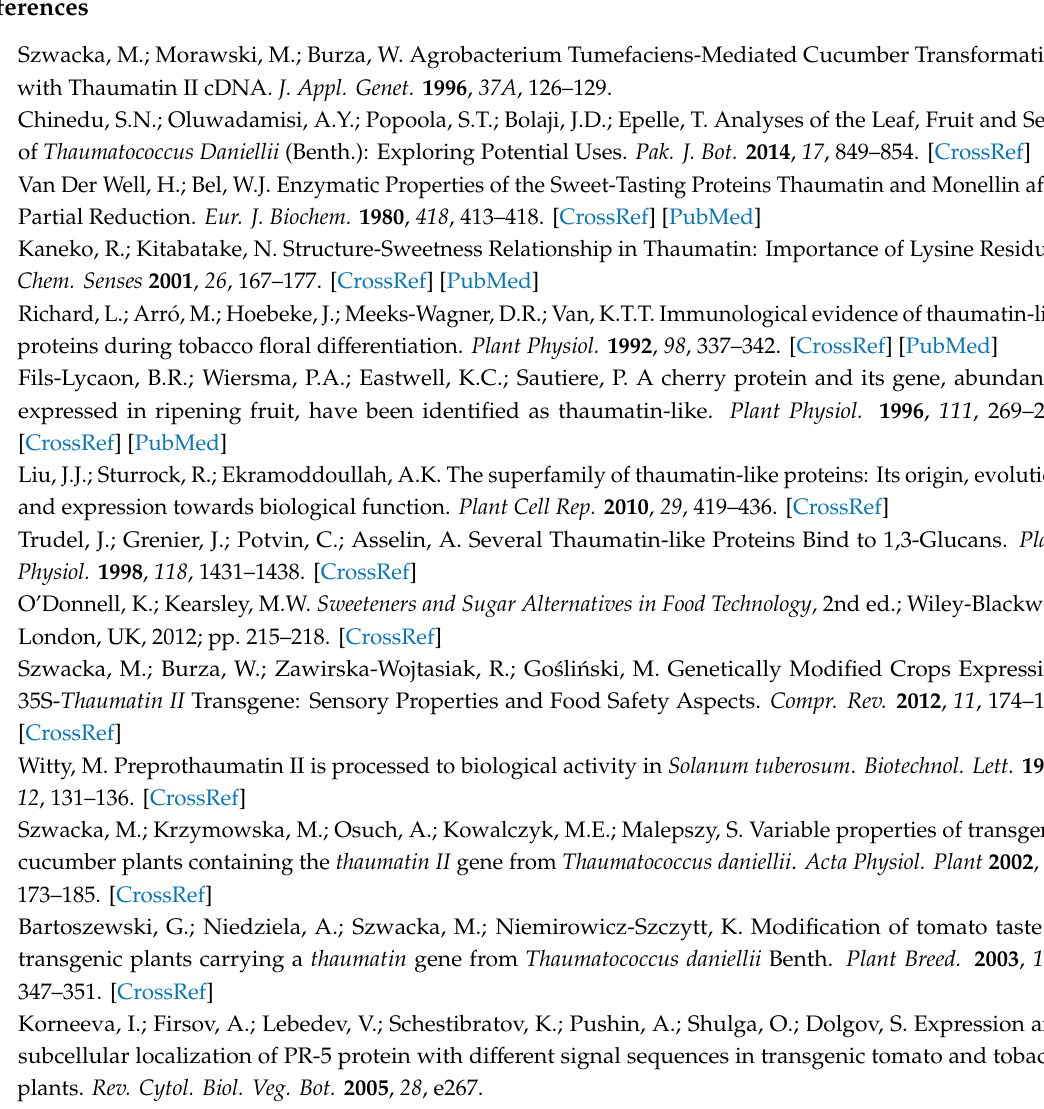
Table S1: Primers for qPCR, Table S2: Statistics of the short reads, Table S3: Results of the qPCR analysis, Table S4: Results of the Gene Ontology assignment, Table S5: Results of the functional annotation, Table S6: Results of miRNAs, Table S7: Results of the promotors analysis with PlantCARE, File S8: Results of the STRING molecular network for NF-Y, File S9: Results of the STRING molecular network for